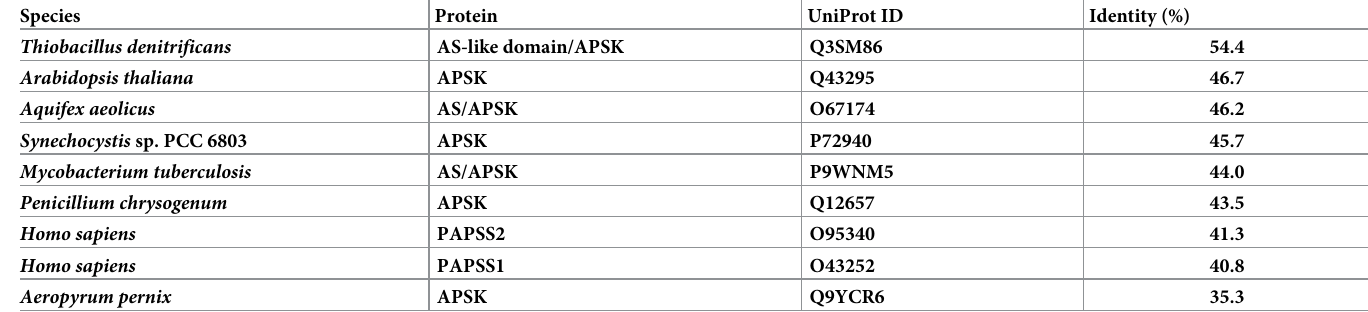
Table 1. Amino acid sequence identity between the APSK domain of E . histolytica and the APSK domain of nine homologues. AS, ATP sulfurylase; APSK, APS kinase; PAPSS, PAPS synthase. Species